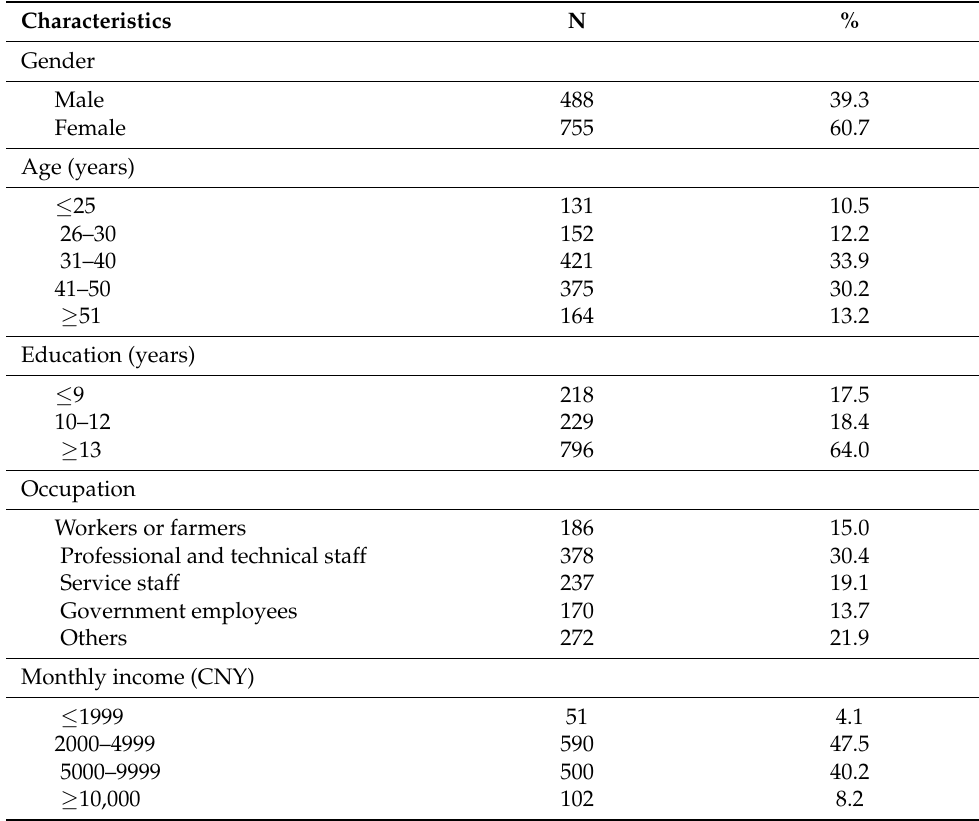
Table 1. Social and demographic characteristics of the study participants.